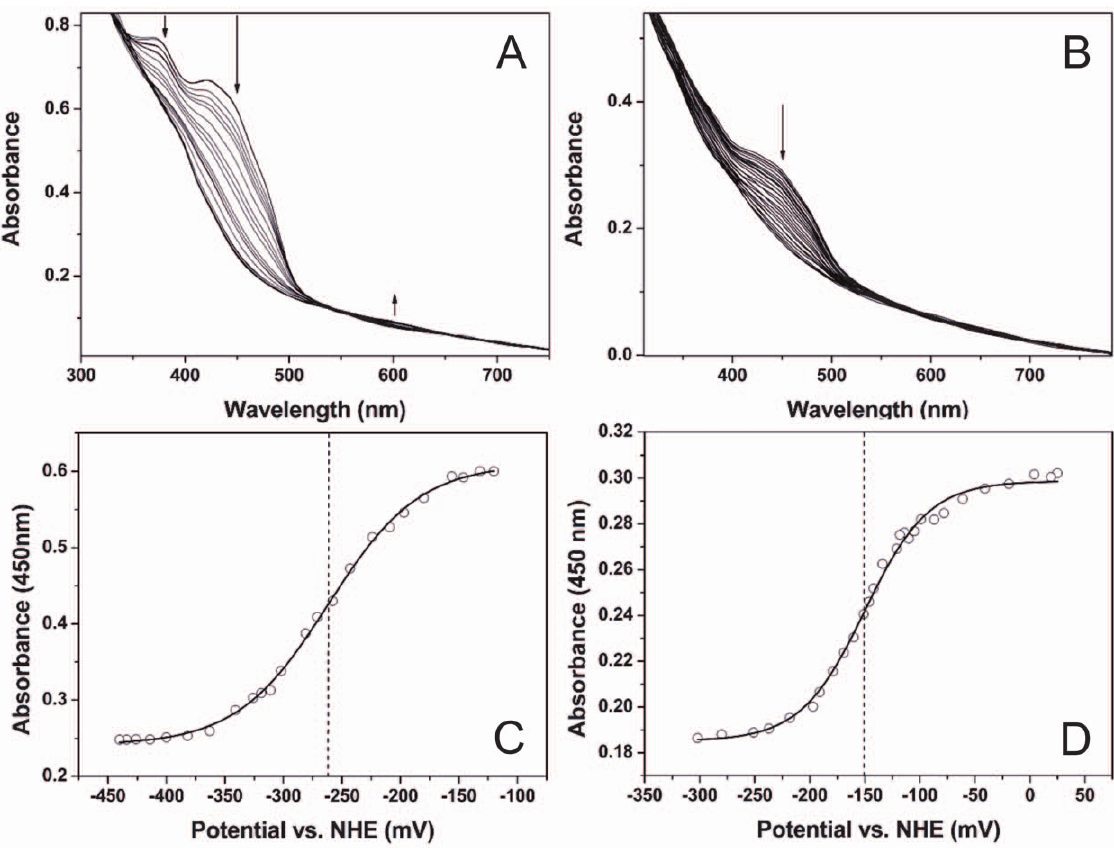
Figure 5. Determination of midpoint reduction potential of PduS. Spectral changes associated with the reduction of PduS (70 m M), in 100 mM phosphate buffer (pH 7.5) at 25 u C with dithionite during the spectroelectrochemical titration. Spectra were recorded after the sample reached equilibrium following each addition of dithionite. The arrow indicates the wavelength at which the maximal changes in spectral properties between oxidised and reduced enzyme occur. ( a ) Shows spectra of aerobically purified PduS housing predominantly flavin during dithionite titration. ( b ) Shows anaerobically purified PduS housing [4Fe-4S] and flavin cofactors during dithionite titration. Arrows indicate directions of absorption change at selected points in these spectra. ( c ) A fit of the spectral data from panel (a) at 450 nm to the Nernst function, giving a midpoint redox potential of the cofactors to be E o = 2 150 6 5 mV. ( d ) A fit of the spectral data from panel (b) at 455 nm to the Nernst function, giving a midpoint redox potential of the flavin to be E o = 2 262 6 5 mV. Midpoint redox potentials are shown by dashed